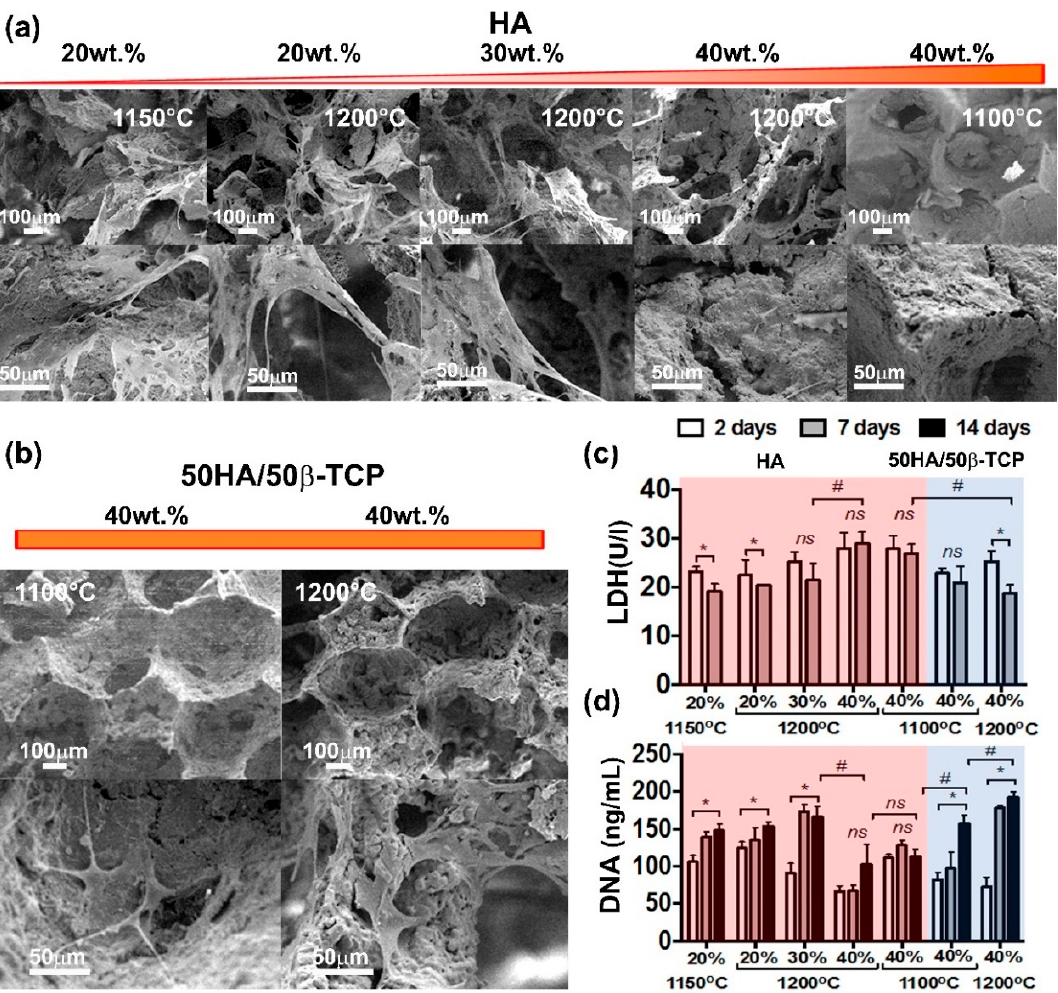
Figure 12. In vitro biocompatibility assessment with hAMSCs. ( a , b ) SEM observations at 14 days after cell seeding; ( c ) Cell viability by LDH; ( d ) Cell proliferation by PicoGreen assay.